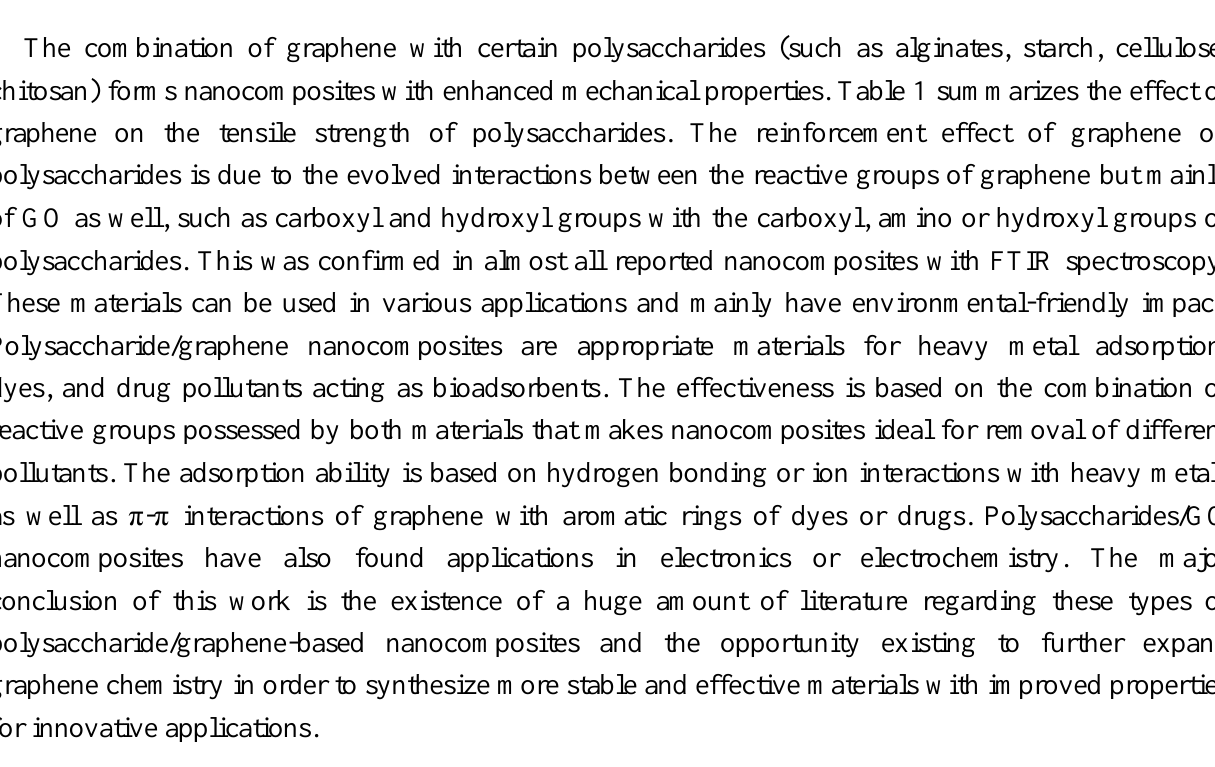
Table 1. The effect of graphene on the tensile strength of